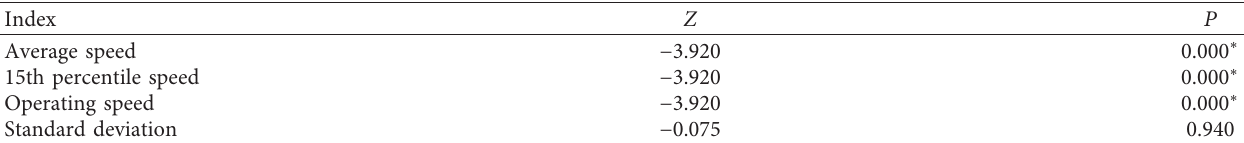
Table 4: Wilcoxon nonparametric test